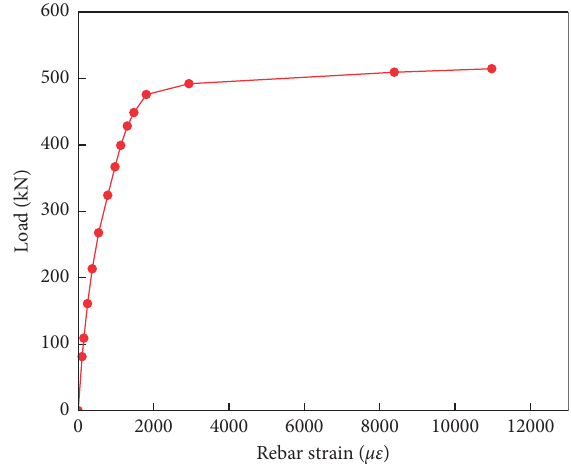
Figure 9: Load-rebar strain curve.